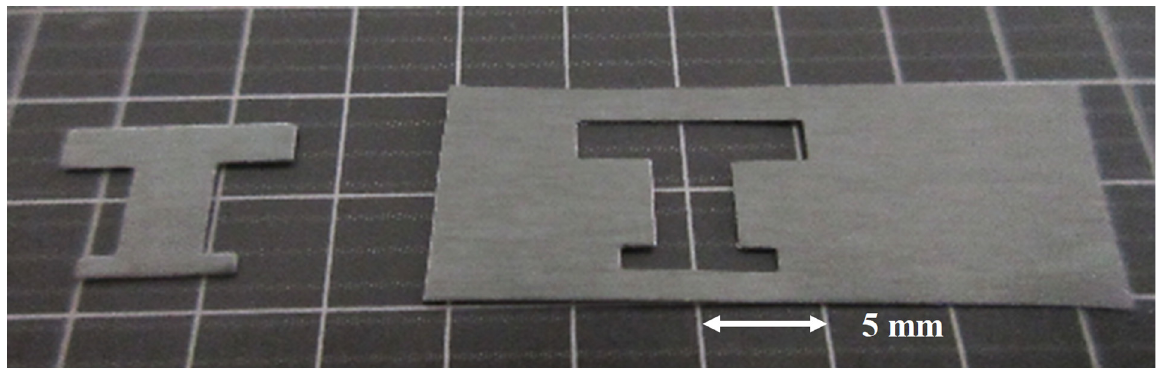
Figure 11. Optical image on the pierced electrical steel sheet and T-shaped skeleton.